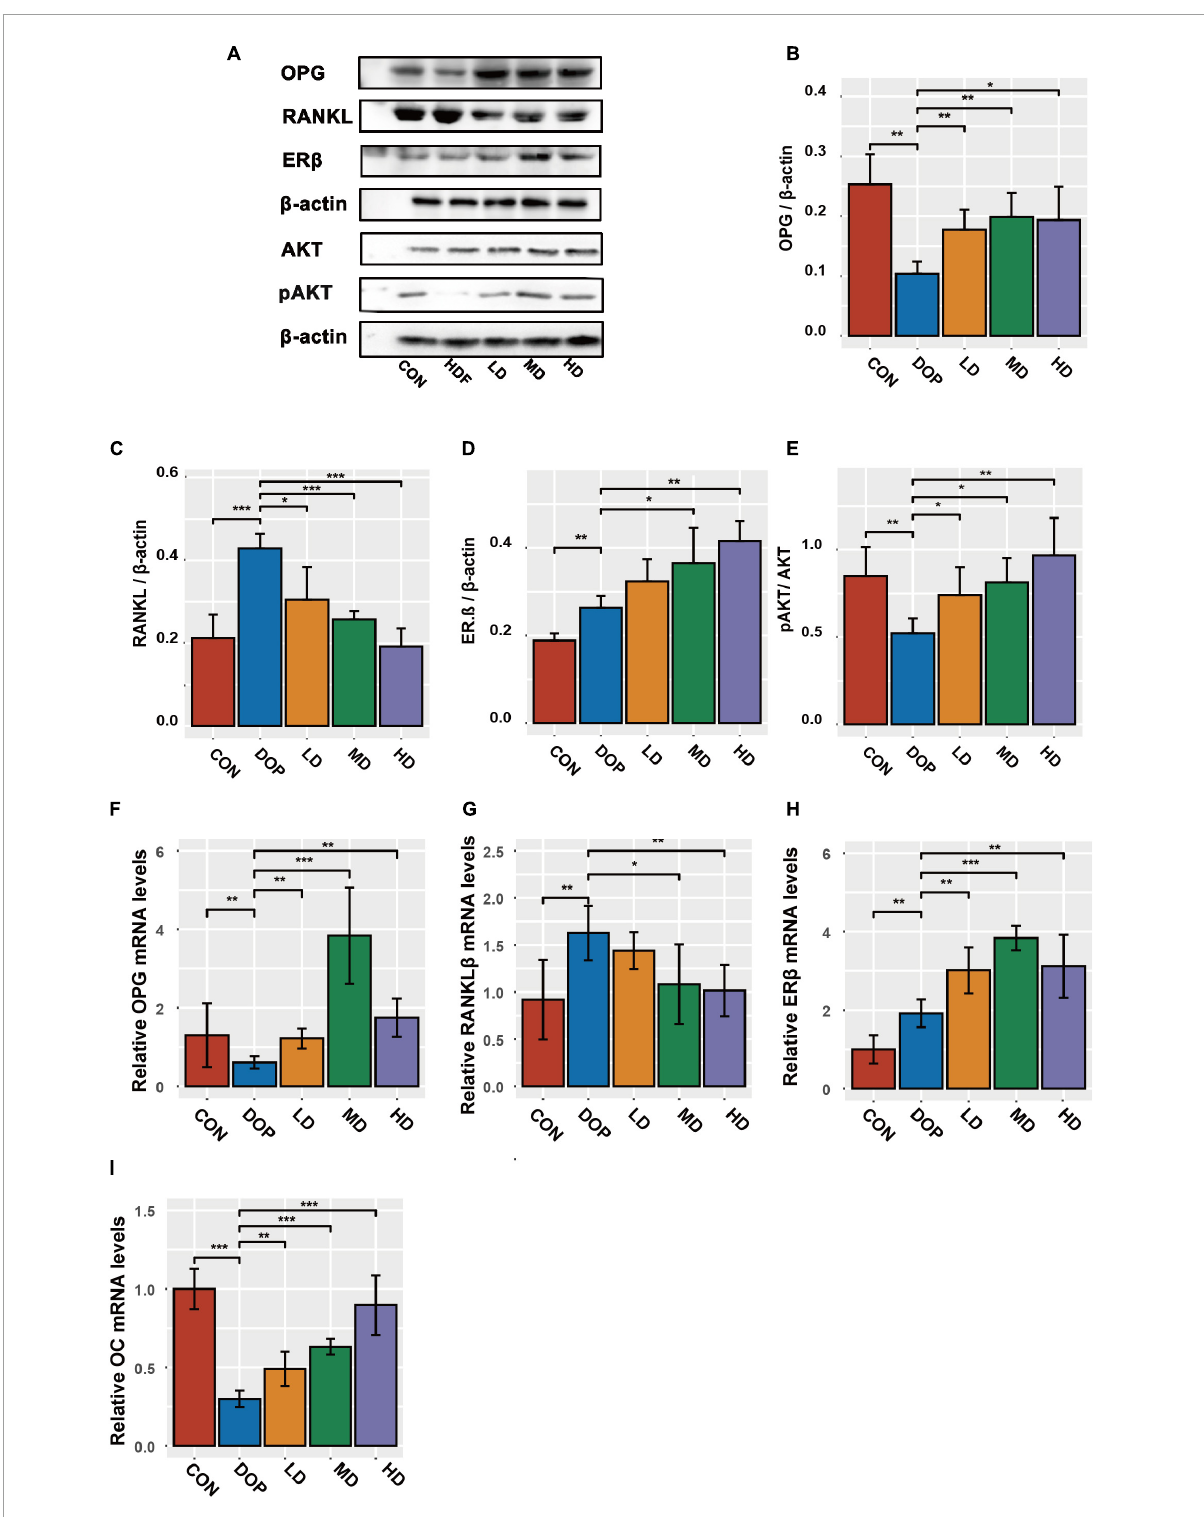
FIGURE6 S-Equol is involved in the regulation of phosphorylation, osteoprotegerin/receptor activator of nuclear factor kappa-B ligand (OPG/RANKL) ratio, and level of estrogen receptor β (ER β ) in the distal part of the femoral metaphysis tissues of diabetic osteoporosis (DOP) rats. (A–E) The expression of key proteins was analyzed using the western-blot method; (F–I) the mRNA amounts of OC, OPG, RANKL, and ER β were analyzed by the RT-PCR method. All data are expressed as the mean ± SD ( n = 5). * p < 0.05, ** p < 0.01, *** p < 0.001 as compared to the DOP